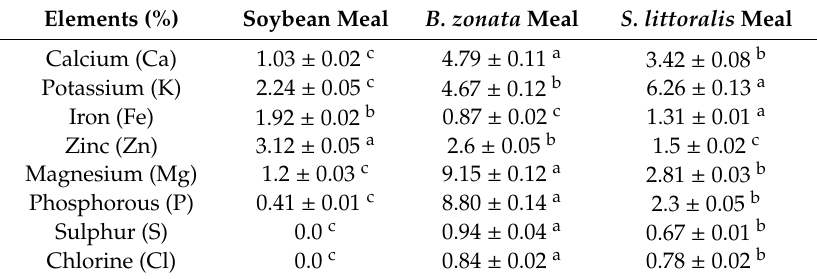
Table 5. Trace element contents detected in soybean, B. zonata and S. littoralis meals in %. Elements (%) Soybean